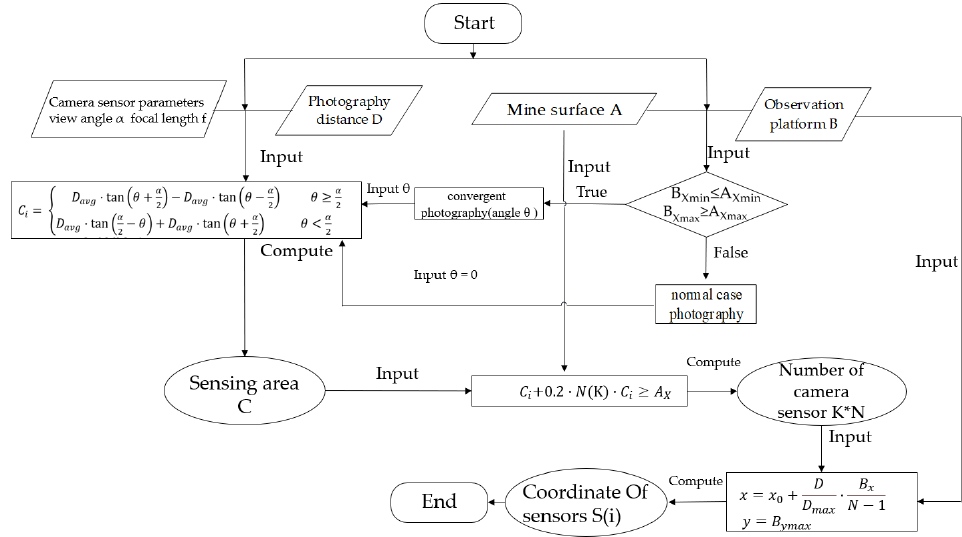
Figure 9. Workflow of the Optimum Camera Deployment algorithm for open-pit mine slope monitoring (OCD4M)